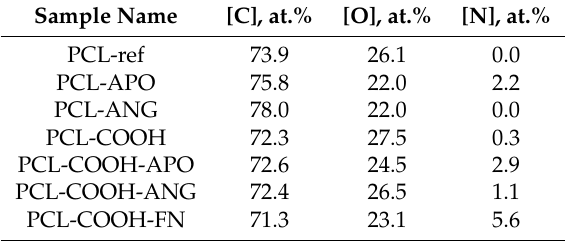
Table 1. Composition of samples (in at.%) derived from X-ray photoelectron spectroscopy (XPS) analysis. The traces of sodium, chlorine, and phosphorus were detected but were not taken into